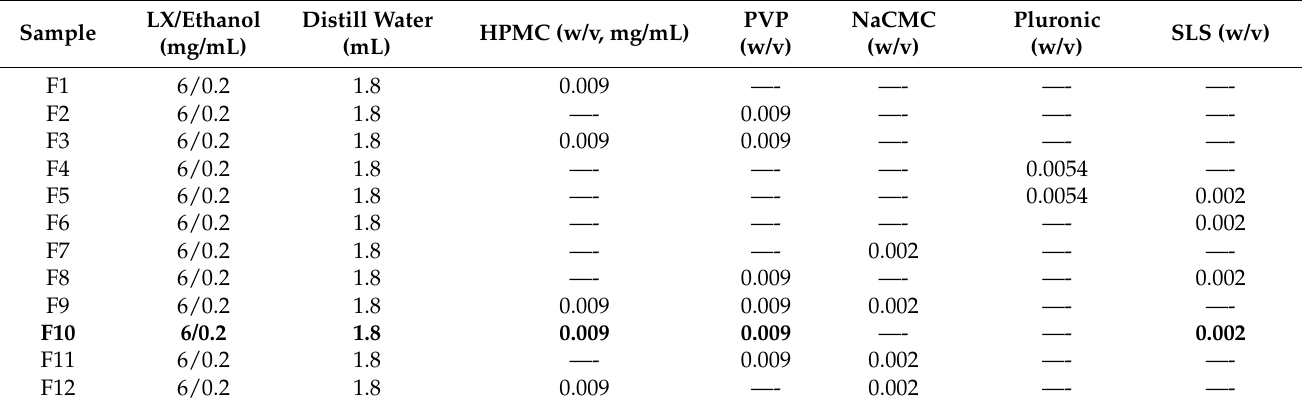
Table 1. Composition of drug-loaded NC formulations (2-mL batch